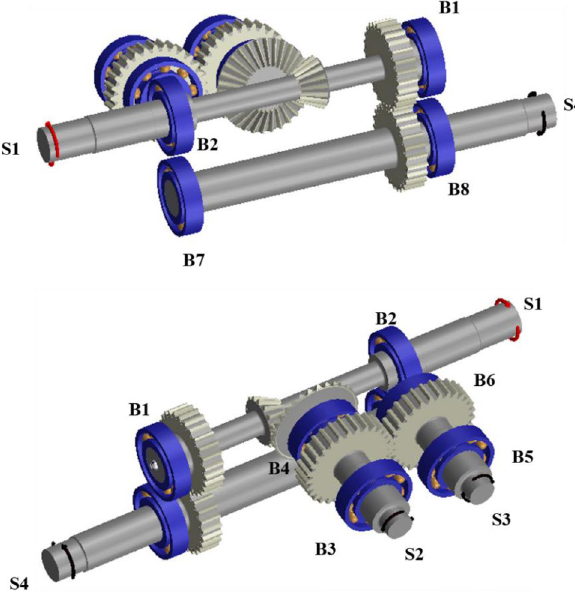
Figure 6. Modified gearbox simulation model of maize harvester.